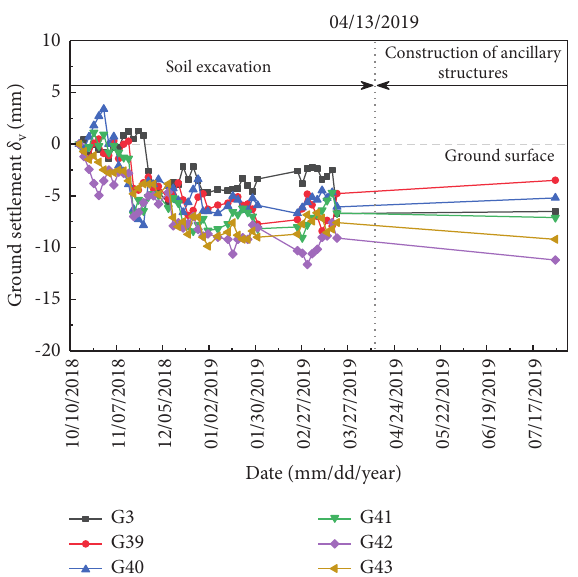
Figure 16: Ground surface settlements at G3, G39, G40, G41, G42, and G43.